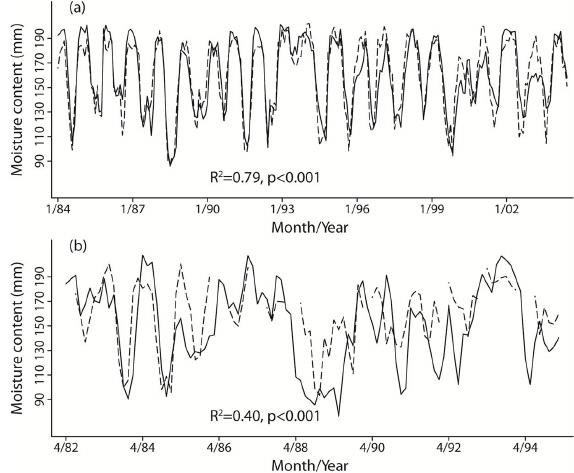
Fig. 6. Comparison between LH-simulated (black line) and ob- served (dashed line) soil moisture in the top 50cm of soil layers in (a) Illinois in the US during the years 1984–2004 (Hollinger and Isard, 1994), and (b) Iowa in the US during the years 1981–1994 (Entin, 1998; Entin et al., 2000). For Illinois soil moisture, only half year (till June) data for 2004 are available. LH-simulated soil mois- ture in Illinois was averaged for all grid cells ranging from 91.25 ◦ W to 88.25 ◦ W and from 37.25 ◦ N to 42.25 ◦ N; a spatial extent that ap- proximately matches the extent of Illinois soil moisture. Measured soil moisture in Iowa was not available for some months and years, but most records were available between April and